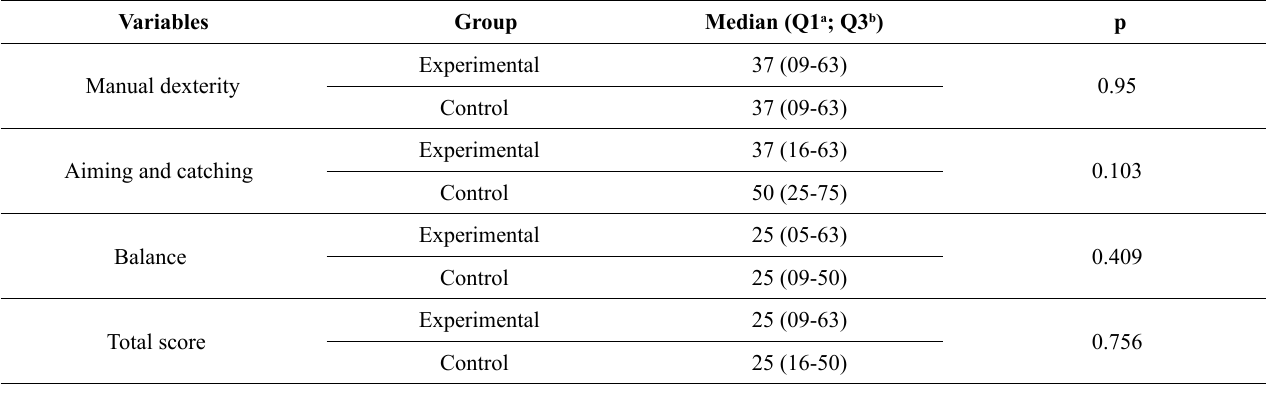
Table 3: MABC-2 test results for the experimental and control groups, shown as percentiles Variables Manual dexterity